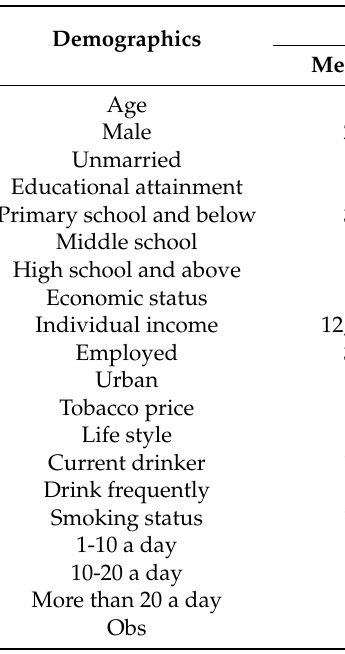
Table 1. Individual socioeconomic and life style characteristics.